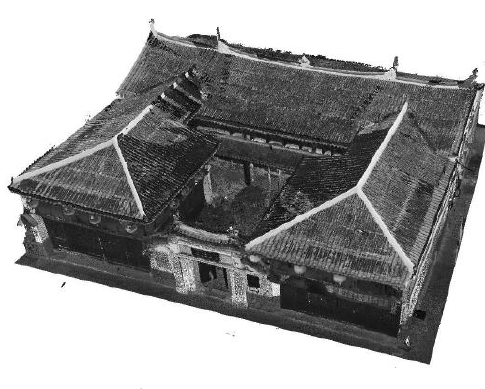
Figure 2 . Point cloud